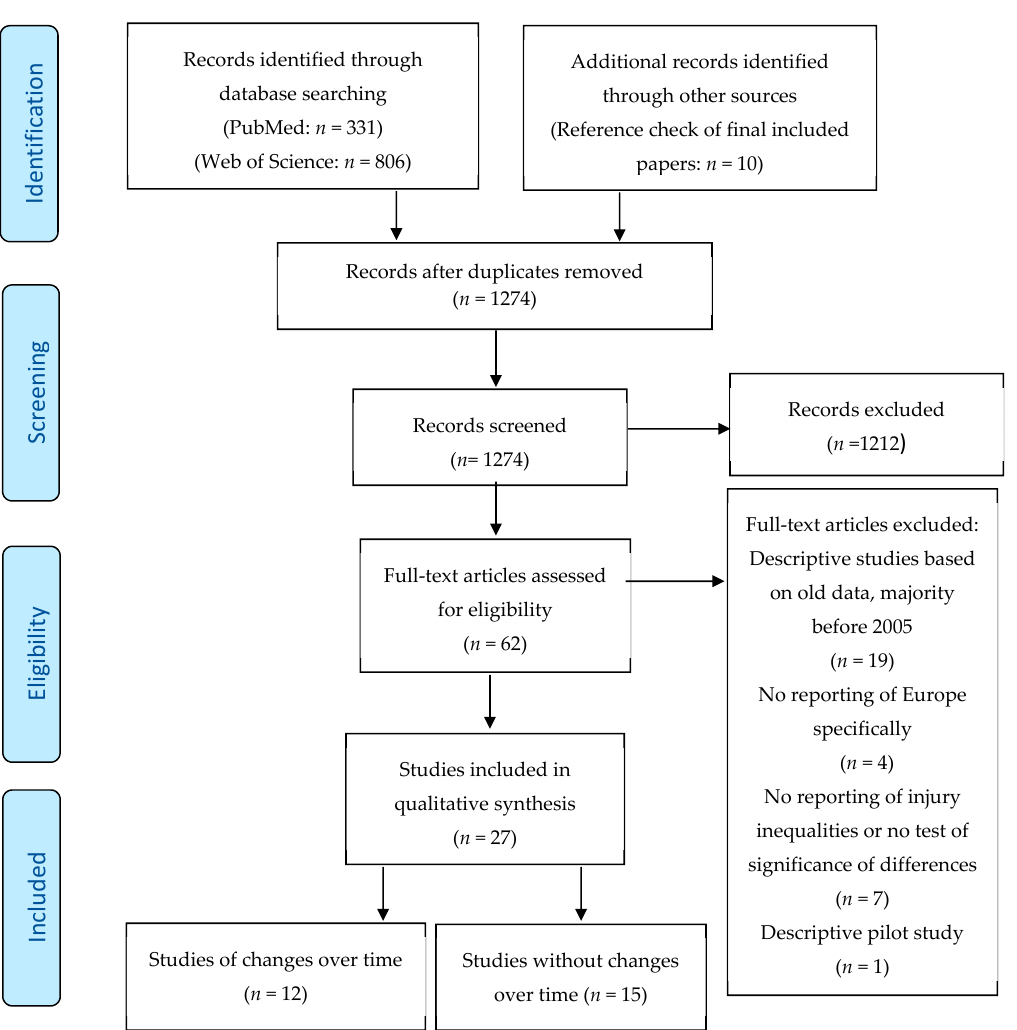
Figure 1. Preferred Reporting Items for Systematic Reviews and Meta-Analysis (PRISMA) flow diagram of studies on injury-related inequalities.